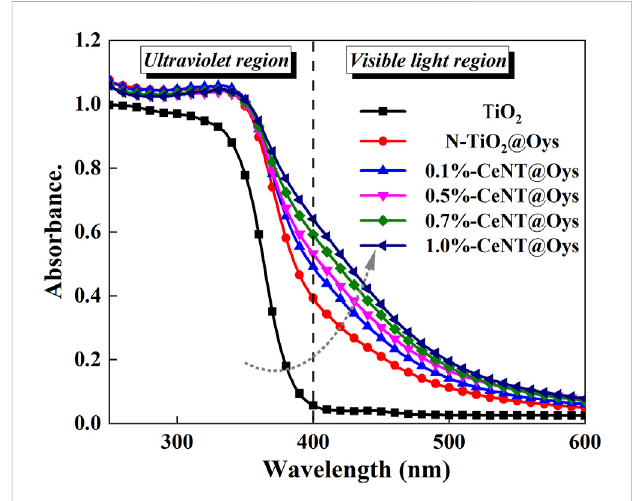
FIGURE 6 UV-vis DRS of pure TiO 2 , nitrogen doped and